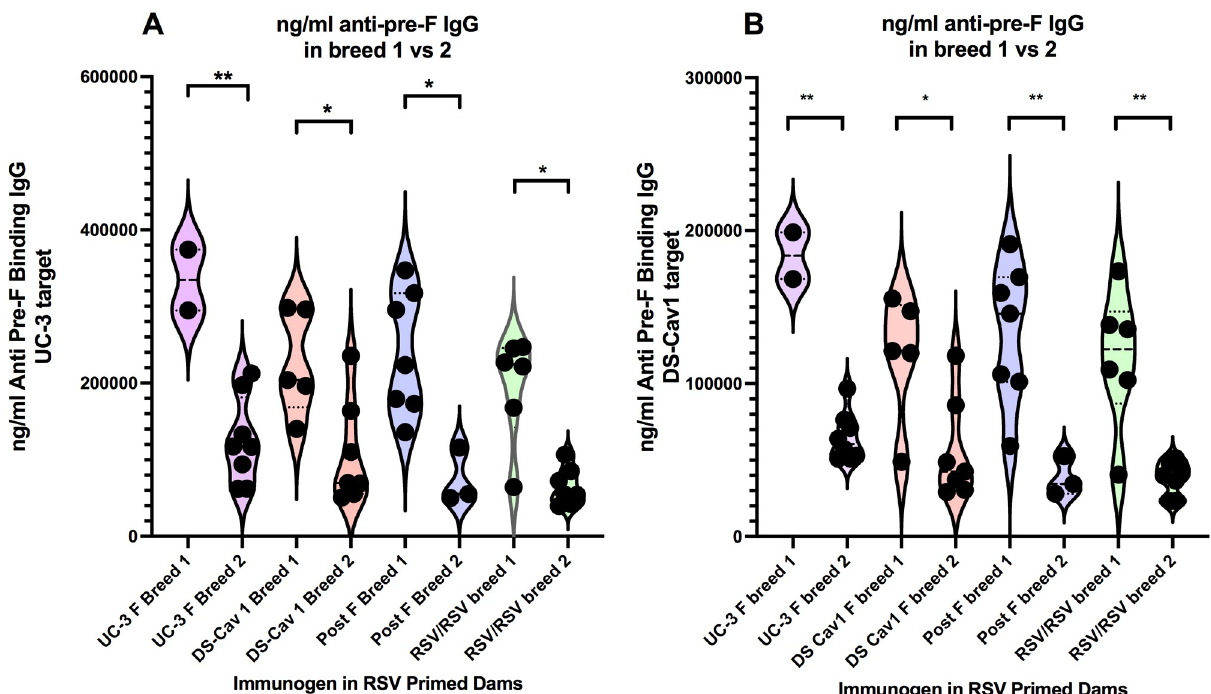
Fig 5. Comparisons of total anti-pre-F IgG in offspring of immunized dams. Shown are direct comparisons of total anti-pre-F IgG (ng/ml) in individual offspring of breed 1 and breed 2 dams immunized with 100 μ g of UC-3F VLP, 100 μ g of DS-Cav1 F VLPs, 100 μ g post F VLPs, or RSV. Sera from offspring of the same dam were pooled since it has been shown that titers from siblings are the same [28]. Pre-F IgG titers at four weeks after birth were determined using as target in ELISA soluble UC-3 F (panels A) or DS Cav1 F (panels B) and shown on a linear scale. Mean is indicated by horizontal black line. Significance of differences between each of the two groups was determined by Student T test. Mean and standard deviation are indicated by dashed and dotted black line, respectively. � p < 0.05; �� p <